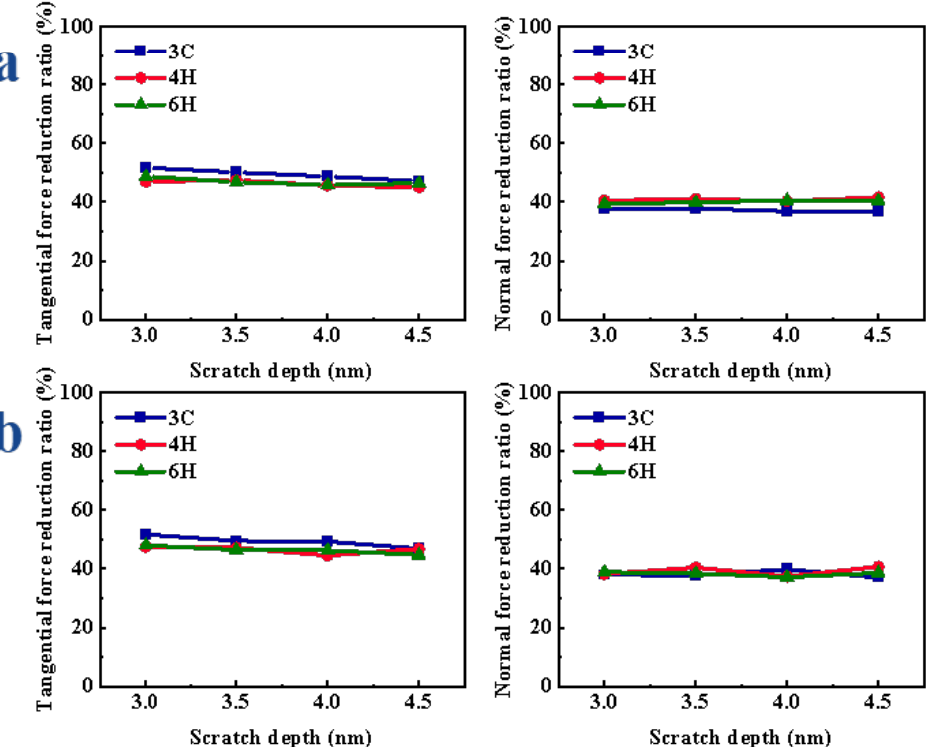
Figure 5. Variation in scratch force reduction ratio of SiC polytypes with different depths: ( a ) Si-face and ( b ) C-face of SiC.